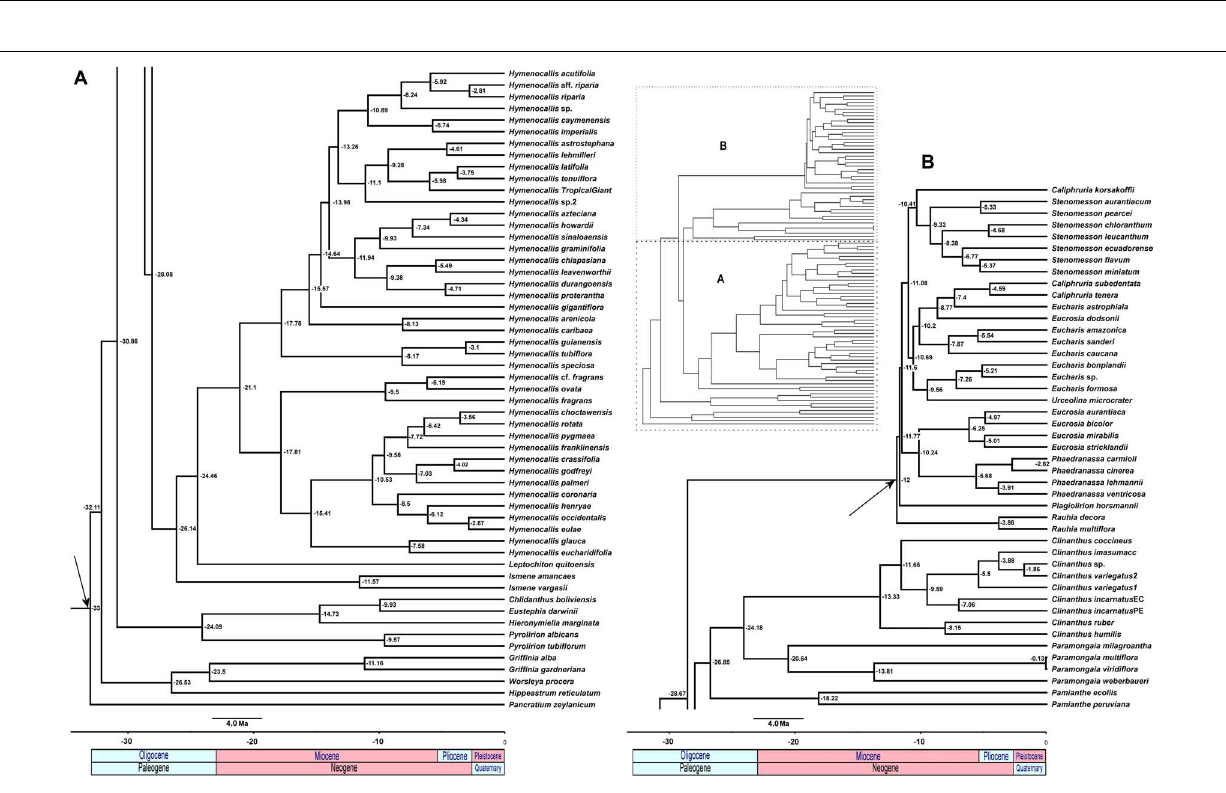
Frontiers in Plant Science |